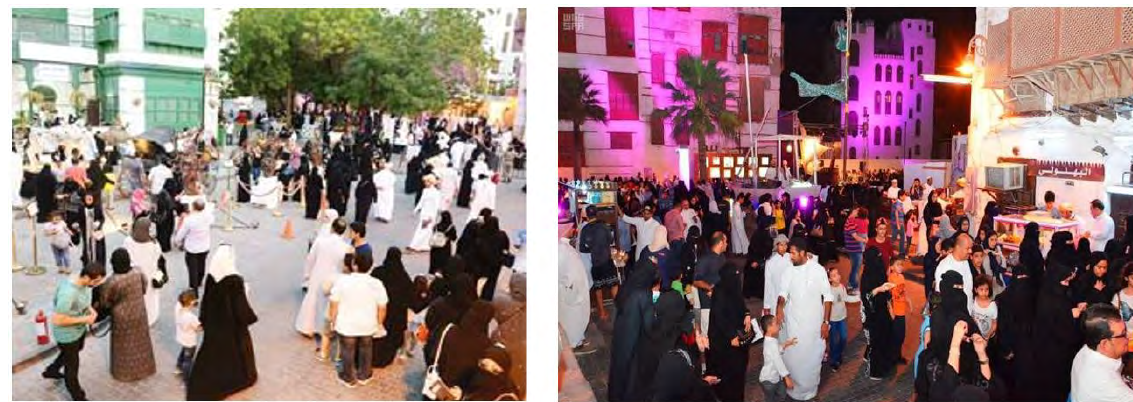
Figure 3. Shows how the space is crowded in night more than in day light